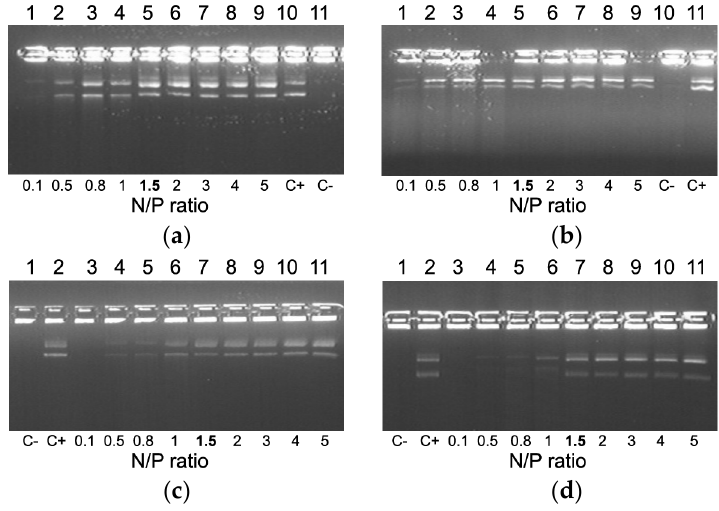
Figure 2. DNase I protective ability of DNA-complexes formed with RGD1 ( a ), RGD2 ( b ), RGD3 ( c ) and RGD0 ( d ) carriers. NH3+/DNA PO4- (N/P) ratio in bold indicates the beginning of DNA protection. C−, “naked” plasmid DNA treated with DNase I, C+, untreated plasmid DNA.